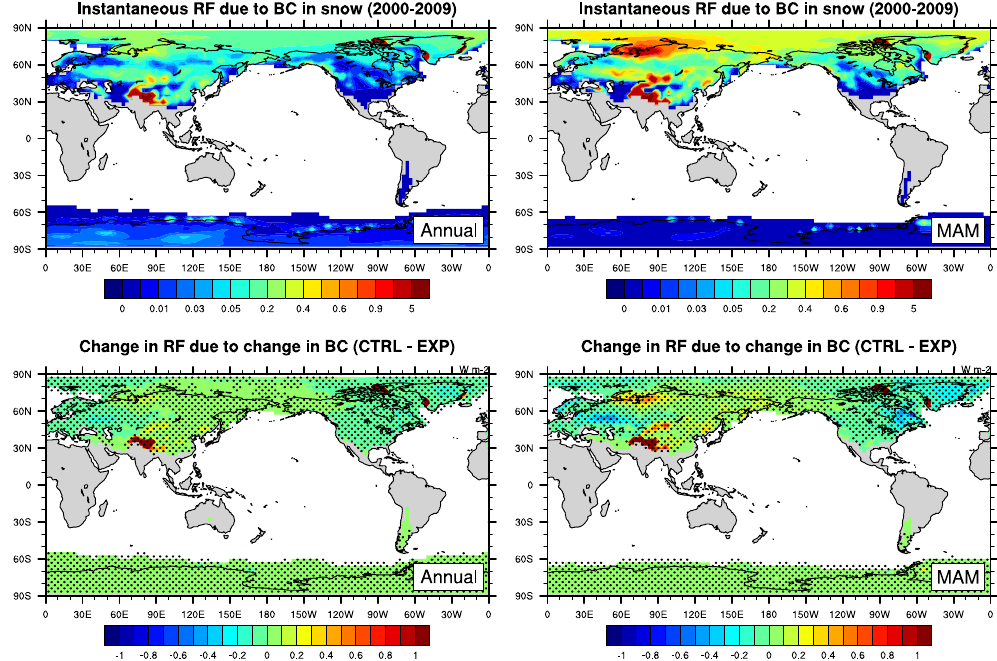
Figure 6. Annual mean (top left) and spring mean (top right) all-sky instantaneous radiative forcing of BC in snow (Wm − 2 ) during 2000– 2009 and annual mean (bottom left) and spring mean (bottom right) radiative forcing changes (Wm − 2 ) due to BC in snow from the 1950s to 2000s. Hatching indicates regions where the results are statistically significant ( p = 0 .